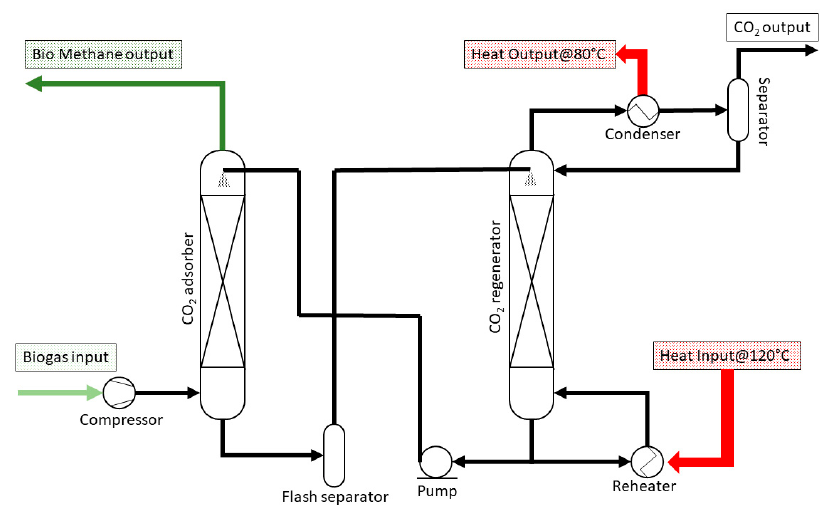
Figure 2. Green Methane hot potassium carbonate (GM-HPC) plant scheme [34].